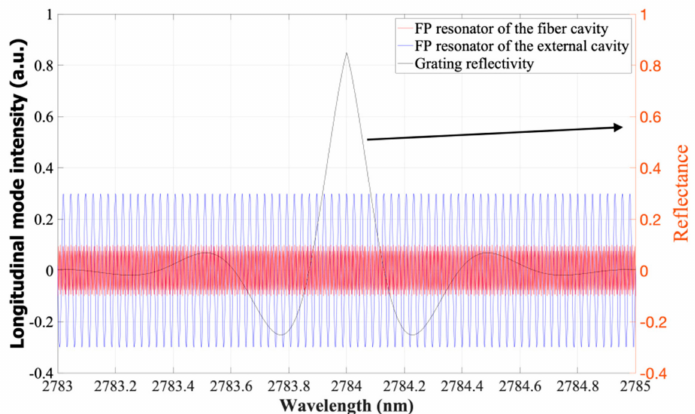
Figure 7. Spectral responses centered at the same wavelength under the influence of all frequency tuning elements (fiber and external cavity modes and grating reflectance spectral